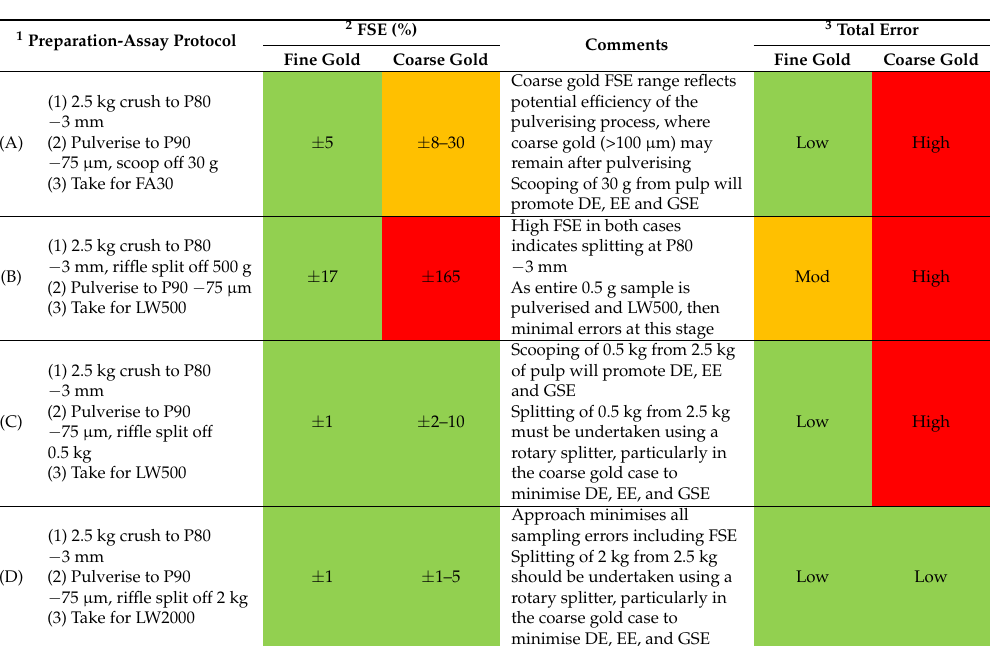
Table 20. Sensitivity of the FSE and sampling errors based on ore type (grade and liberation diameter) and sample